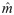
Comparison of the distance to criticality between the hemisphere containing the epileptic focus and the contralateral hemisphere.a Branching process approximation of activity propagation in the brain. Both excitatory and inhibitory connections are summarized to an effective excitation. Depending on the branching parameter m, dynamics are stable (m < 1), unstable (m > 1) or critical (m = 1). b, c Hypothetical scenarios of seizure generation. The epileptic focus might, in general, operate closer to criticality and consequently enter the supercritical regime in an unpredictable manner because of small fluctuations (scenario A). Alternatively, dynamics might systematically drift towards instability before seizure onset. If that drift is sufficiently slow, seizures might be predictable (scenario B). d The branching parameter m^ of neuronal activity in MTL across recordings and patients shows no significant difference between ipsilateral and contralateral hemisphere (mixed effect ANOVA with patientID as random effect). e Estimated m^ in ipsilateral and contralateral hemisphere for multiple recordings of two exemplary patients. While several patients showed a consistent difference between hemispheres across recordings, this difference is not predicted by the location of the epileptic focus (orange: reference recording, red: pre-seizure recording, see S2 Fig for all patients). f Comparison of the branching parameter m^ in ipsilateral and contralateral hemisphere for different subregions of the MTL, (hippocampus (H), amygdala (A), parahippocampal cortex (PHC) and entorhinal cortex (EC)). The hippocampus shows a just significant difference between ipsilateral and contralateral hemisphere, with a smaller m in the ipsilateral hemisphere. The other subregions show no significant difference (p < 0.05/4 required after Bonferroni correction). Box plots show median and quartiles, while whiskers extend to the rest of the distribution, except for outliers (points beyond 1.5 x interquartile range).